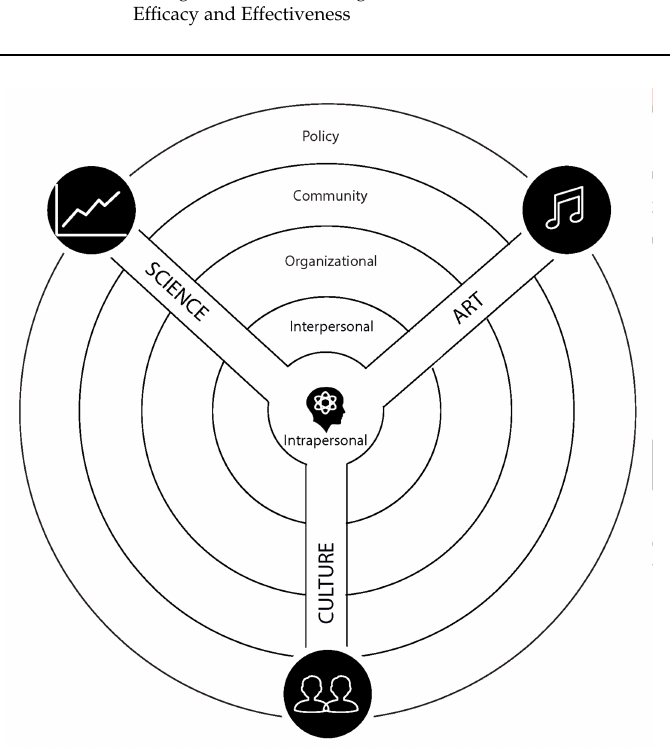
Figure 2. The Multisensory Multilevel Health Education Model (MMHEM) integrates art, culture, and science into multiple levels of influence of the SEM (intrapersonal, interpersonal, organizational, community, and